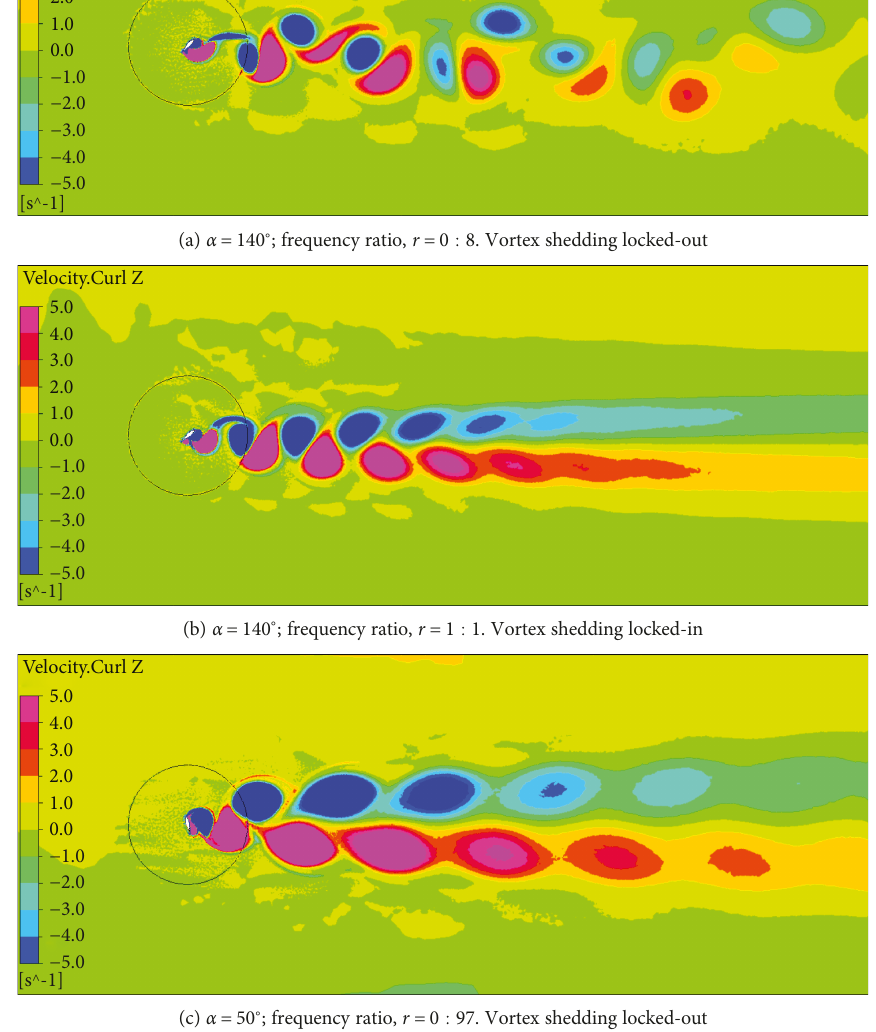
Figure 8: Instantaneous vorticity fi eld for pitching motion at di ff erent conditions: α (positive) vorticity (in pink), and clockwise (negative) vorticity (in